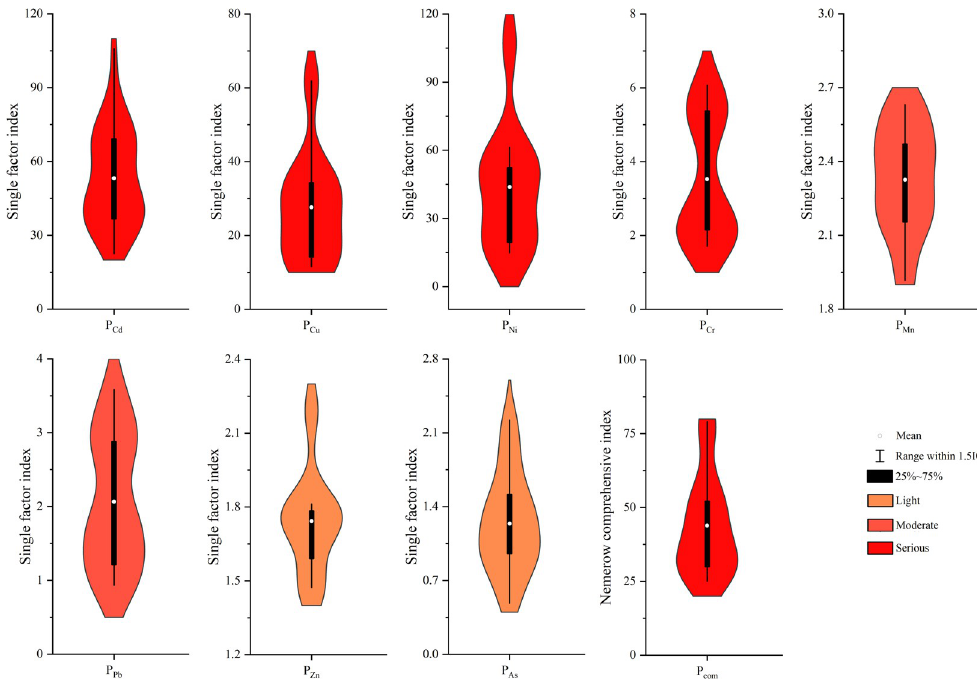
Fig 2. Descriptive statistics for the heavy metal pollution